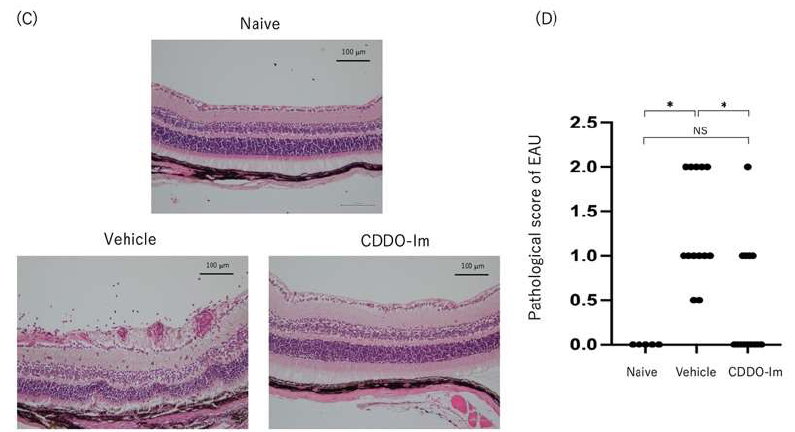
Figure 7. Amelioration of EAU by CDDO-Im treatment. Mice were immunized with IRBP peptide and vehicle or CDDO-Im was administered on days 0, 2, 4, 6, 8, 10, 12, and 14 after immunization. ( A ): Fundus images and clinical score of EAU in naïve mice ( n = 5), vehicle-treated mice ( n = 34 mice) and CDDO-Im-treated mice ( n = 33 mice). Vehicle-treated mice (on day 18 after immunization) re- vealed severe retinal vasculitis (clinical score: 3) and CDDO-Im-treated mice (on day 18 after im- munization) showed mild retinal vasculitis (clinical score: 1). Naïve mice showed no inflammatory changes on day 21. ( B ): Clinical score was evaluated on days 10, 14, 18, and 21 after immunization. The mean ± standard deviation for each group is shown. Asterisk indicates p < 0.05 versus vehicle- treated mice. Statistical analysis was performed according to ANOVA followed by Bonferroni tests . ( C , D ): HE sections and histopathological score of EAU in naïve mice ( n = 5 mice), vehicle-treated mice ( n = 13 mice) and CDDO-Im-treated mice ( n = 14 mice) on day 21. Either eye per mouse was used for histopathological analysis. The mean ± standard deviation for each group is shown. Asterisk indicates p < 0.05 versus vehicle-treated mice. Statistical analysis was performed according to ANOVA followed by Bonferroni test. Scale bar: 100 µ m. NS: not significant.